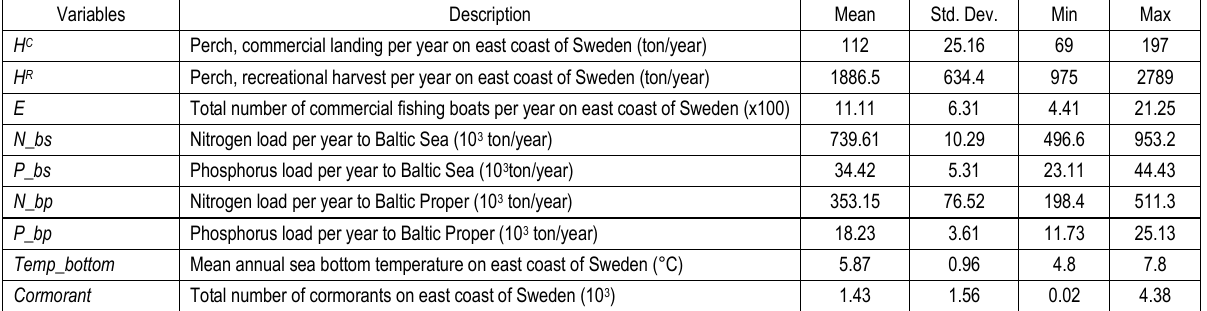
Table 1. Descriptive statistics used in models,